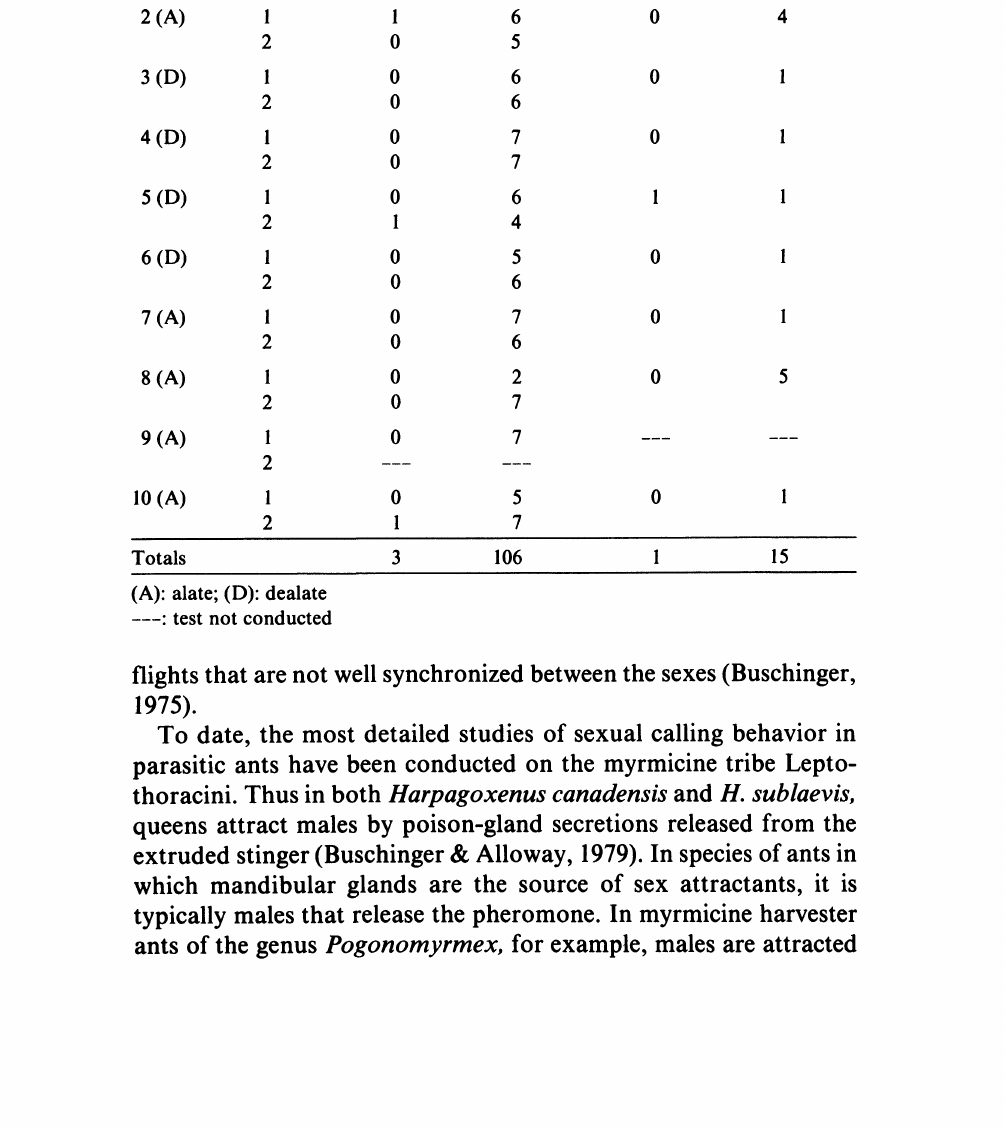
Table 1. Response of Polyergus males to sex pheromone of queens. Values shown are the number of males (n 7) active before and after squashing either the mandibular gland or the remaining